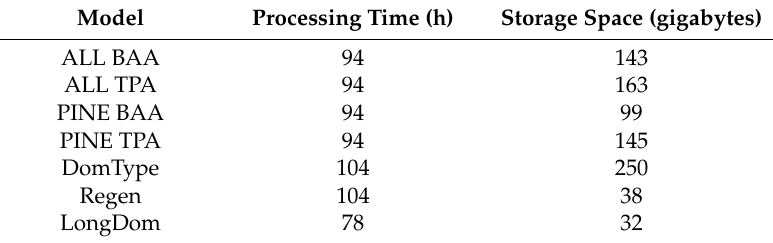
Figure 5. Example of DomType, Regen, and LongDom percent cover surfaces for an enlarged sub-section of the Apalachicola National Forest. DomType is displayed as three band color composite with red, green, and blue colors corresponding to pine, hardwood, and non-forest classes, respectively, while Regen and LongDom are displayed as a single band color stretch. Table 6. Total processing time and size of